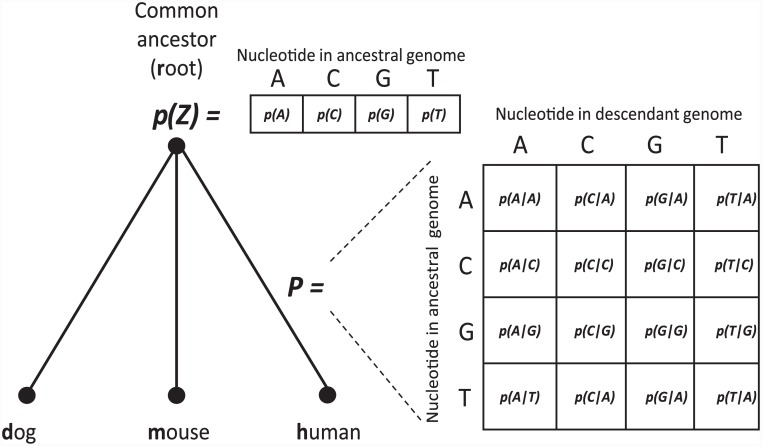
Substitution matrix and vector of ancestral probabilities.We assume a simplified phylogenetic tree in which the branches leading to the extant organisms (human, mouse and dog) trifurcated from their last common ancestor. For each position within a SS, a separate substitution matrix P was constructed for each of the three phylogenetic branches (only the human substitution matrix is shown for simplicity). Rows in P correspond to nucleotides in the ancestral genome, and columns, to nucleotides in the descendant genome (here, human). An element of P is the conditional probability p(X|Z) that a nucleotide Z at this position in the ancestral genome was replaced with nucleotide X in the descendant genome. Elements of the vector of ancestral probabilities p(Z) are probabilities of each nucleotide in the ancestral genome.